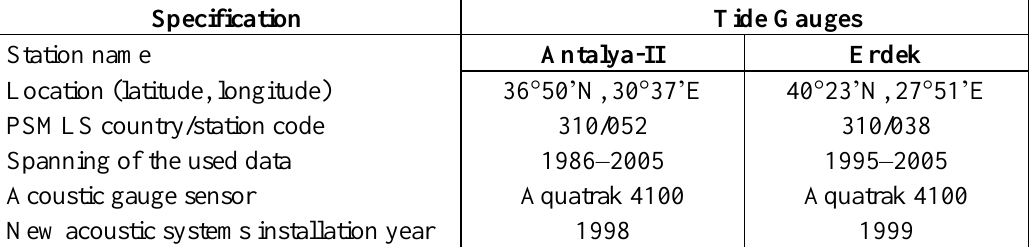
Table 1. Specifications of Antalya-II and Erdek tide gauges [2].